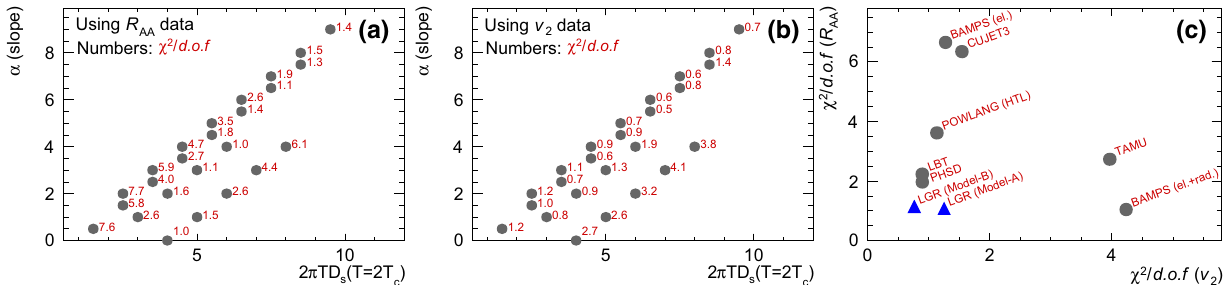
( T ) obtained at T = 2 T α (y-axis) and 2 π T D s c (x-axis), respectively. c Comparison of χ 2 / d . o . f for various models. See the legend and text for